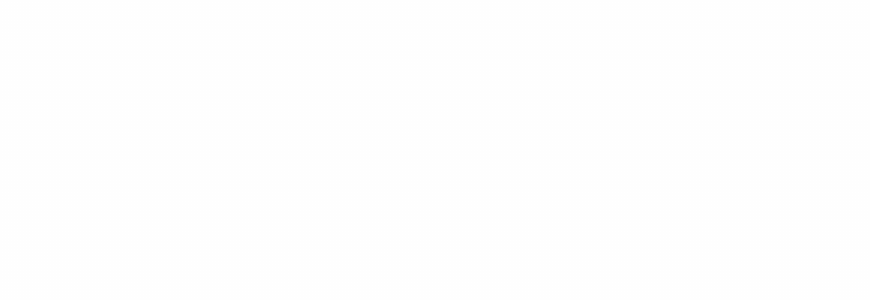
Gene expression in expanded and standard mesencephalic cultures. The diagrams show the relative quantization (mean +/- SEM) of the intermediate filaments light neurofilament (NFL), medium neurofilament (NFM) and glial fibrillary acidic protein (GFAP) amplified product compared to that of the hypoxanthine phosphoribosyl transferase (HPRT, internal standard), assessed by RT-PCR. Data are expressed as ratio NFL/HPRT, NFM/HPRT, GFAP/HPRT. Expanded MES cultures were analyzed at 12 DIV after the treatment with either bFGF for 6 DIV, or bFGF and SHH for the first 6 DIV, or bFGF for the first 6 DIV and consequently addition of fetal bovine serum (FBS) and horse serum (HS), or plated in standard conditions (see Experimental